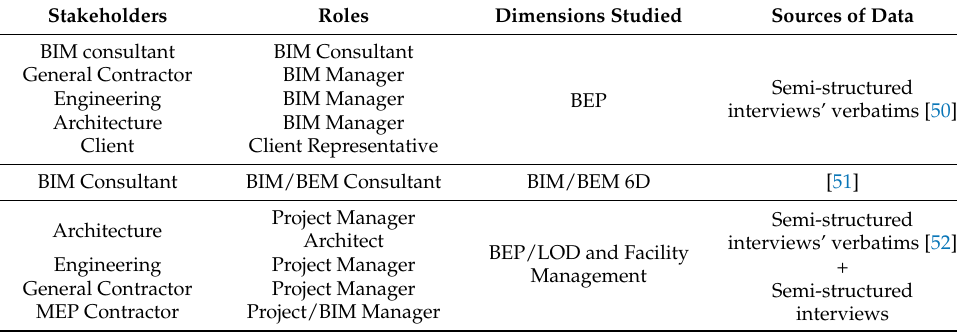
Table 1. Sources of data and data collection.